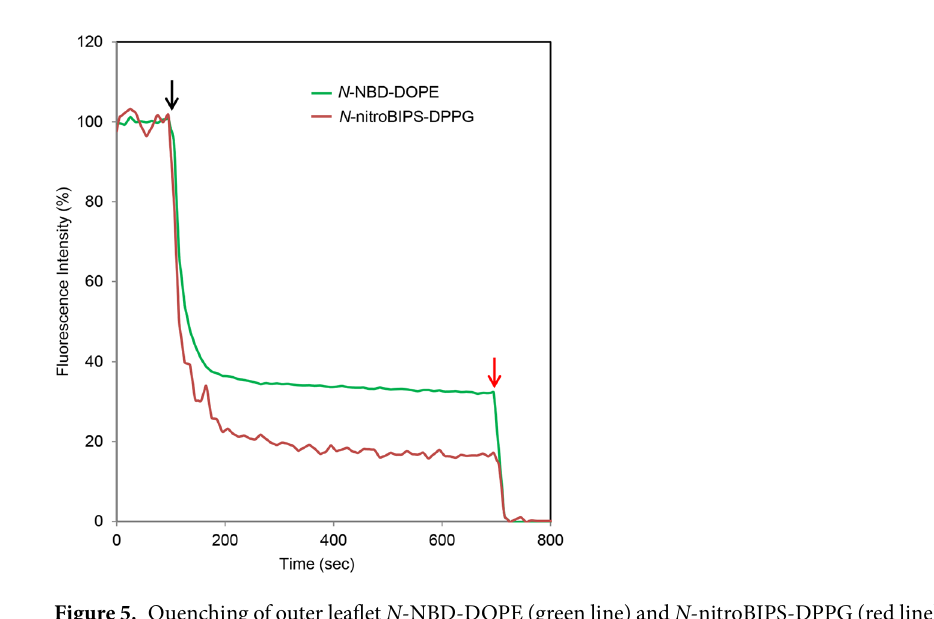
During the initial phase, dithionite rapidly quenched NBD as well as N -nitroBIPS fluorescence, followed by a slow but steady quenching. The slow fluorescence decrease during extended exposure to the reducing agent is more likely associated with dithionite leakage to the inner leaflet, than to spontaneous flip-flop of the fluo- rescence emitting probe 24 . NBD fluorescence was reduced to 63% during the initial phase. Taking the decrease in turbidity into account during the final quenching, about 70% of N -NBD-DOPE is estimated to be present in the outer leaflet of the liposomes. The diameter of SUVs prepared by ethanol injection has been reported to be ~30 nm 25 . Assuming a bilayer thickness of ~5 nm, the ratio of the surface area between the outer and inner leaflet is 2.25:1. Consequently, ~69% of phospholipids should theoretically be present in the outer SUV leaflet, which is consistent with the corrected experimental results. In contrast to N -NBD-DOPE, N -nitroBIPS-DPPG fluores- cence was reduced by ~80% during the initial quenching phase. Considering the error induced by Triton X-100 reduction of turbidity, nearly 90% of N -nitroBIPS-DPPG fluorescence was quenched during the initial phase. Increased leakage of dithionite due to the presence of N -nitroBIPS-DPPG can be excluded as N -nitroBIPS-DPPG and N -NBD-DOPE were incorporated simultaneously in the same liposomes. Similarly, liposome size and thus ratio between inner and outer leaflets were identical between the N -nitroBIPS-DPPG and N -NBD-DOPE experiments as liposomes from the same preparation were used. Also, the slow second phase quenching rate of N -nitroBIPS-DPPG is comparable to the rate exhibited by N -NBD-DOPE, suggesting that the spontaneous